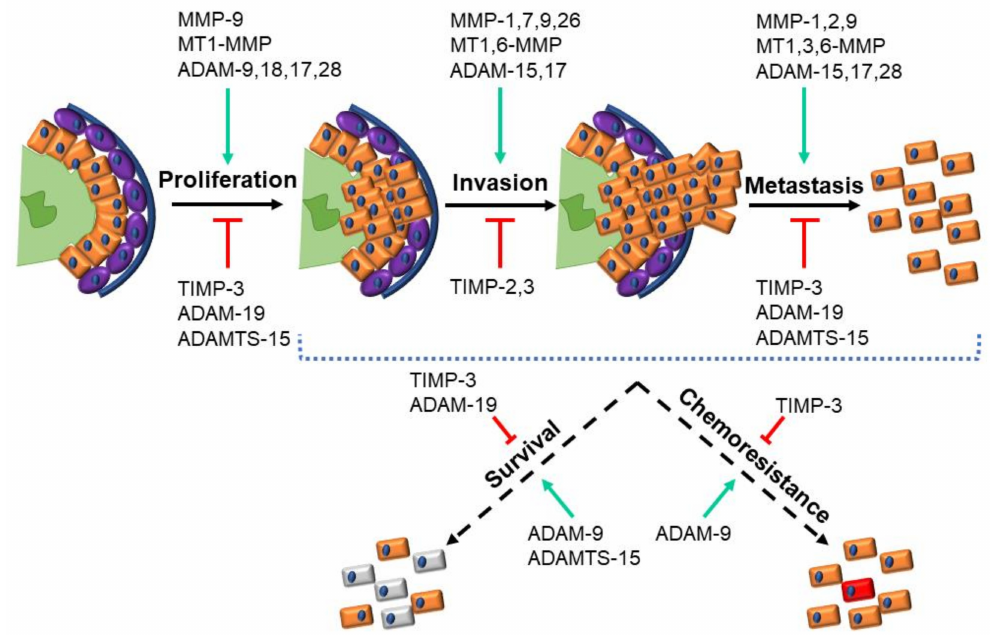
Figure 2. Metzincins and their regulators in prostate cancer. Schematic representation of prostate cancer progression highlighting the key cellular functions that are modulated by the indicated metzincin superfamily members, along with the regulatory Tissue Inhibitor of Metalloproteinase (TIMP) proteins (green: Lumen, orange: Luminal cells, purple: Basal cells, and blue: Basement